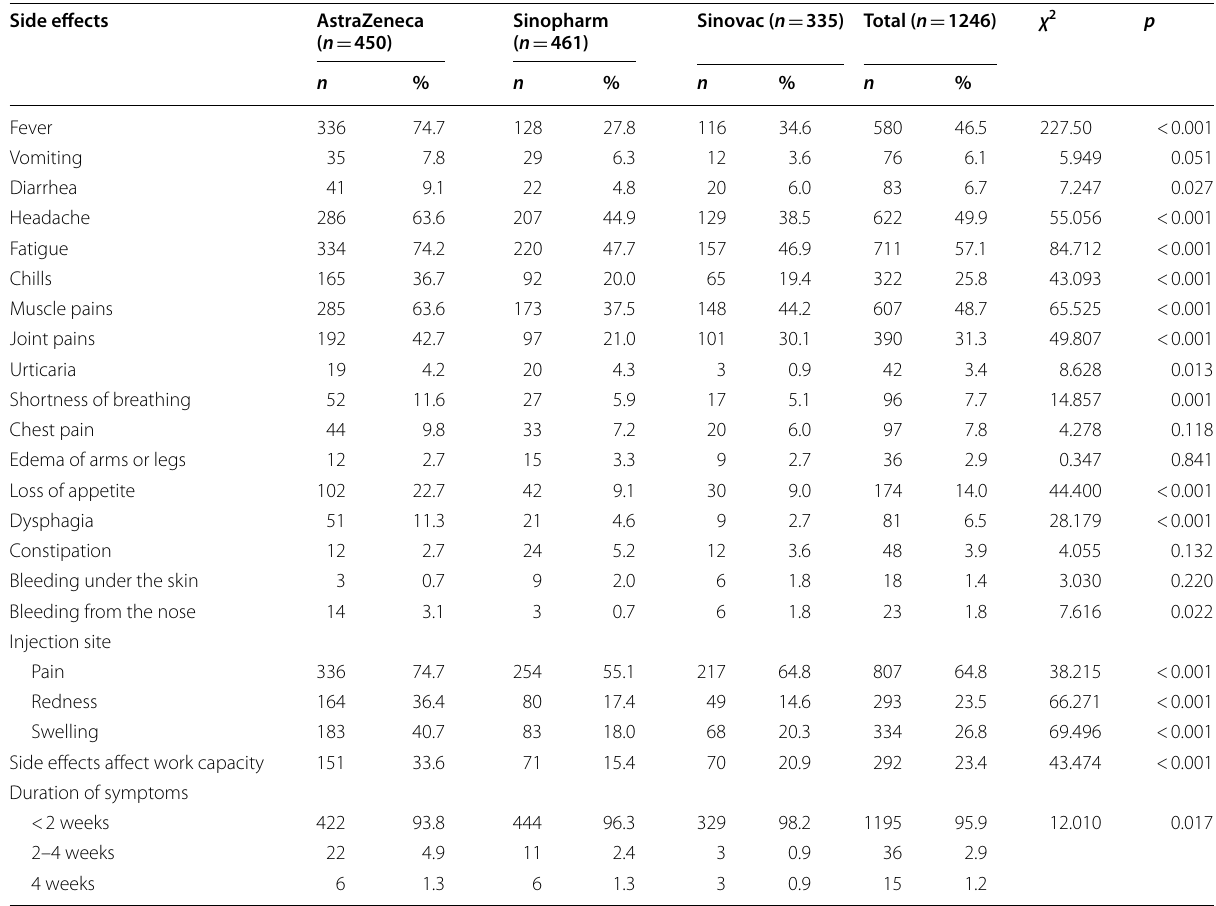
Table 3 Self-reported side effects by type of vaccines Side